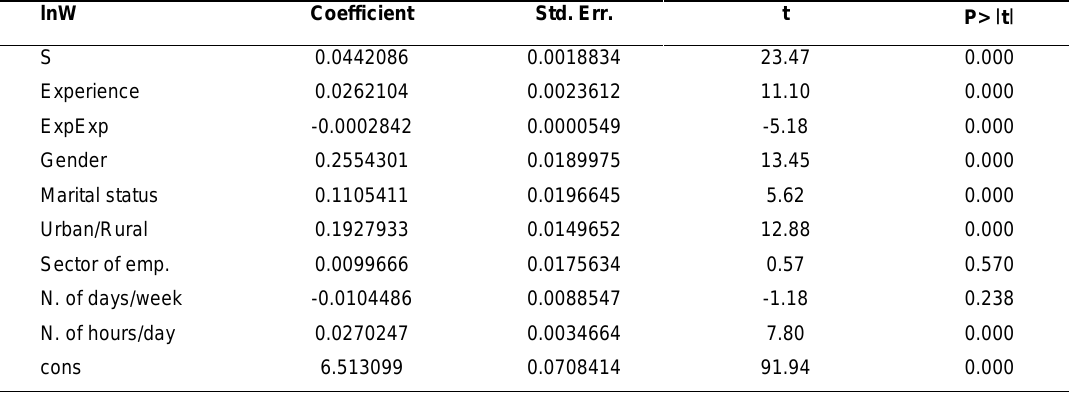
Table 2: The Results of Estimation of Earnings Function